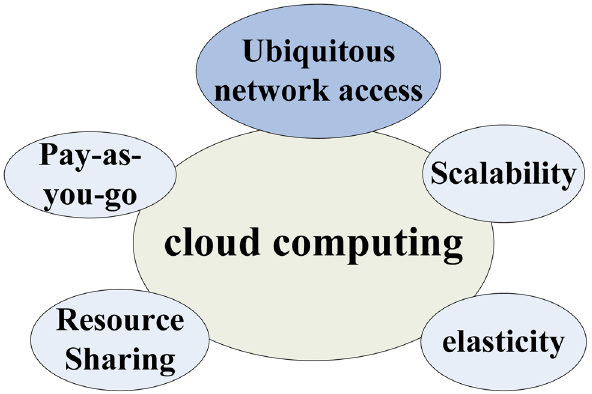
Figure 1: Cloud computing